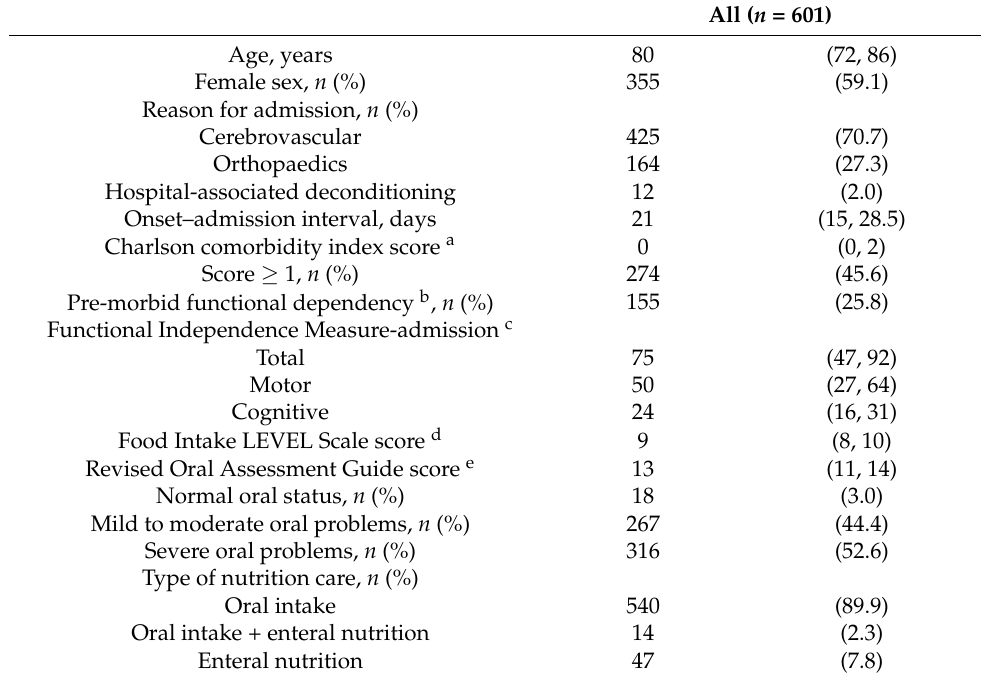
Table 1. Characteristics of 601 patients admitted to convalescent rehabilitation